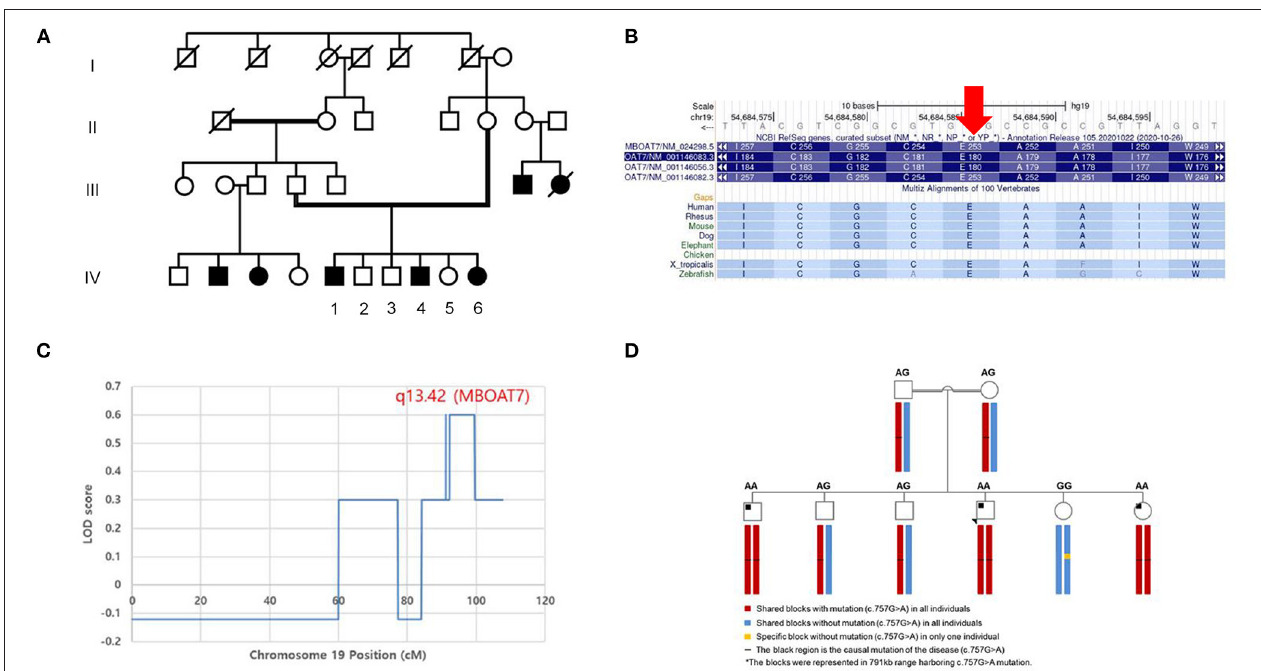
FIGURE 2 | Pedigree and genetic analysis of the homozygous variant of MBOAT7 (c.757G > A) in the consanguineous family. (A) The parents of the patients were distant relatives and there were four other family members (two paternal cousins and two maternal cousins) who had intellectual disabilities. Among the siblings, the three patients with a variant of MBOAT7 had intellectual disability, motor developmental delay, and seizures in common. (B) The 253rd amino acid (glutamic acid), which is mutated in these three patients, is highly conserved across the species. The segregation analysis was conducted to determine the penetrance of the variant in this family. (C) The highest logarithm of the odds (LOD) score (which was twice that of the other regions) was found in the region of chromosome 19 (19q13.42), where MBOAT7 is located ( P -value < 0.05). (D) We performed haplotype analysis of the region harboring the c.757G > A variant of MBOAT7 . A haploblock with the variant was shared by all of the individuals, except one unaffected wild-type sibling (IV-5). All affected individuals (IV-1, 4, and 6) were identified to have a homozygous haploblock, whereas their parents and two unaffected siblings (IV-2, 3) were